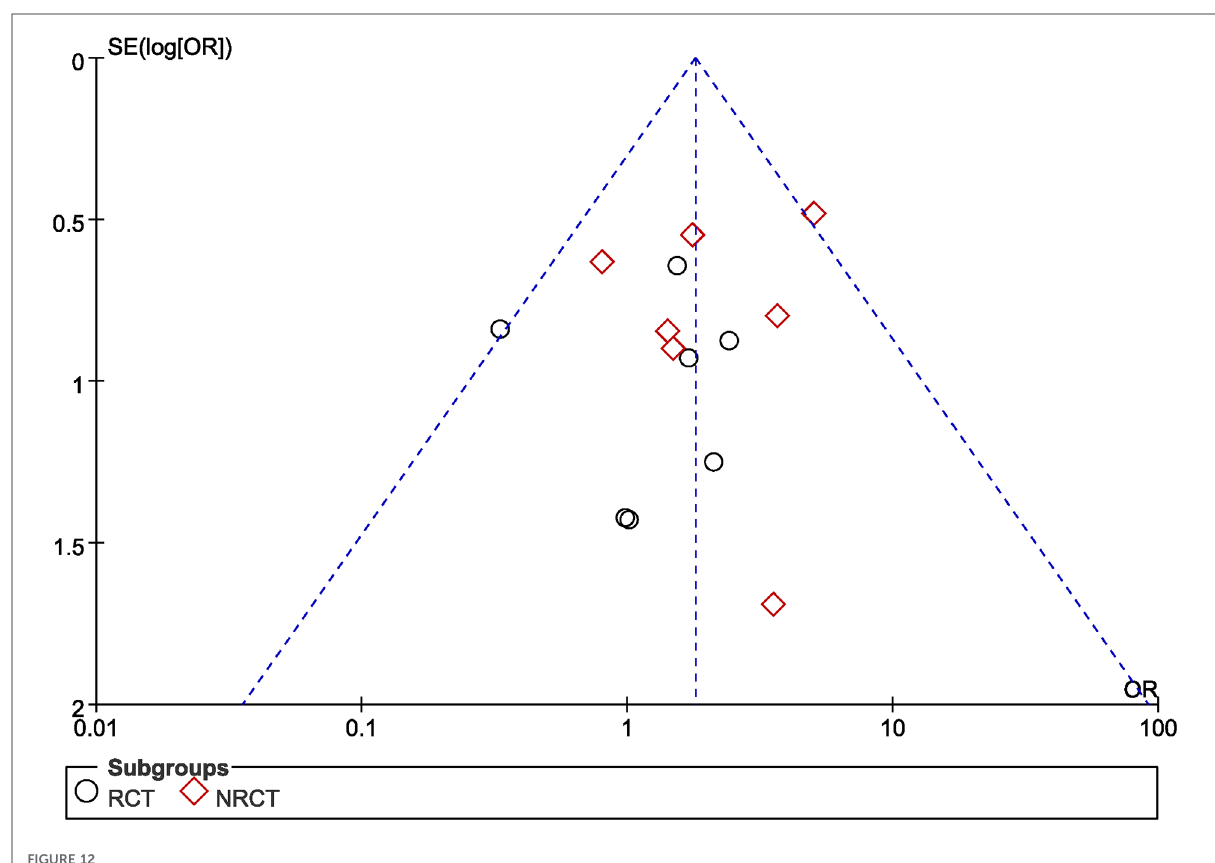
FIGURE 12 A funnel plot showing publication bias for ulnar